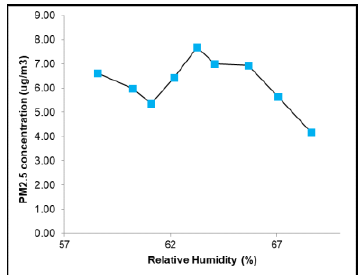
Figure 15. PM 2.5 concentration changes with the increase of relative humidity (%)